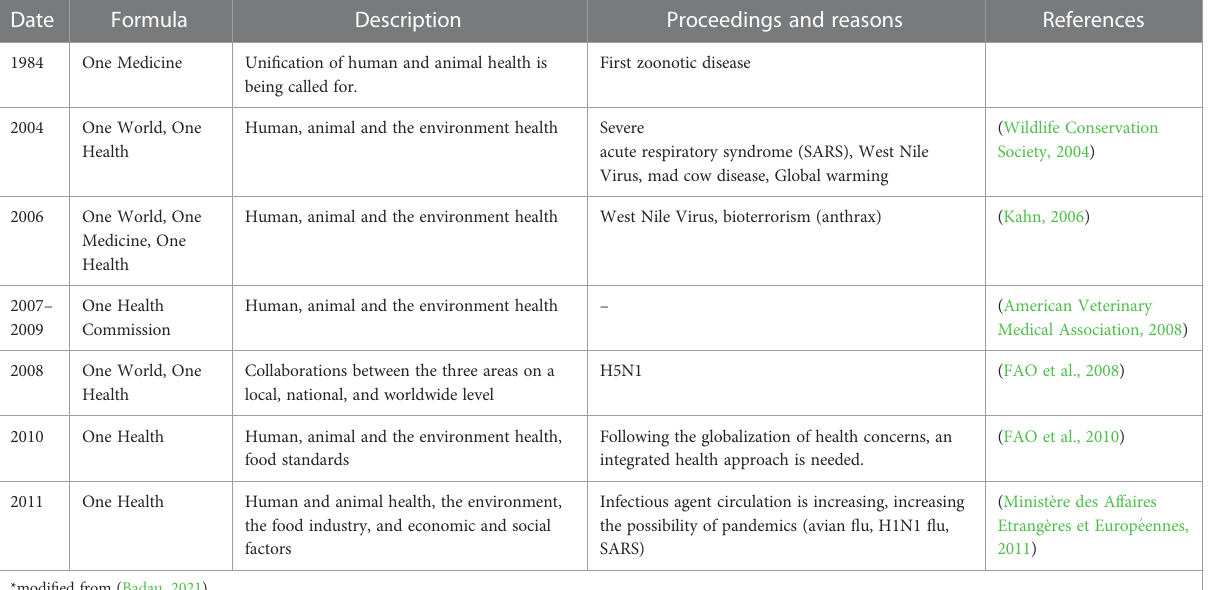
TABLE 1 Formulas and descriptions for the One Health